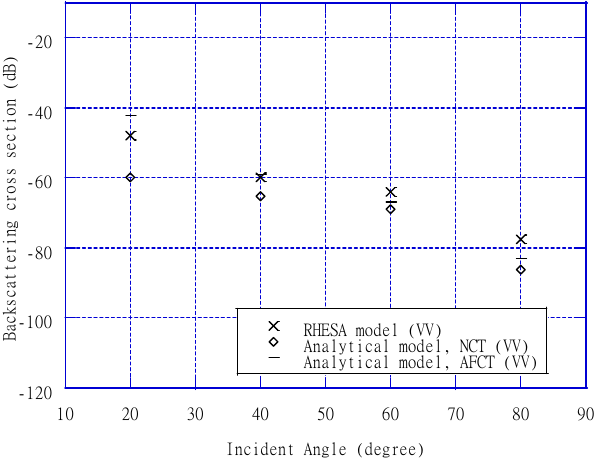
Figure 7. Comparison between theories for backscattering cross section of an elliptical disc scatterer